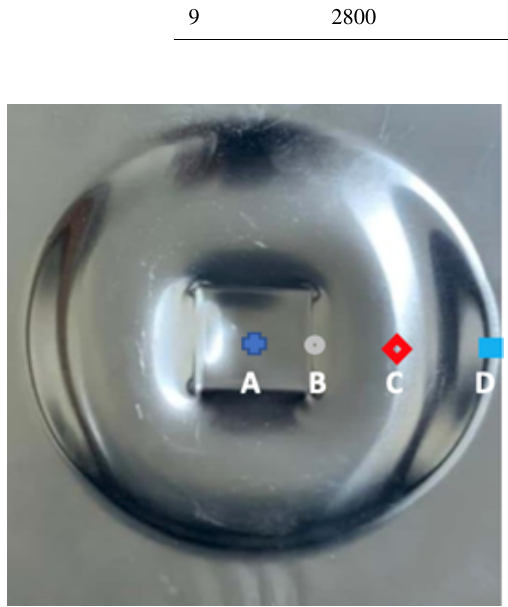
Figure 12. Velocity profile investigated at four points on the de- formed Al 6061-T6